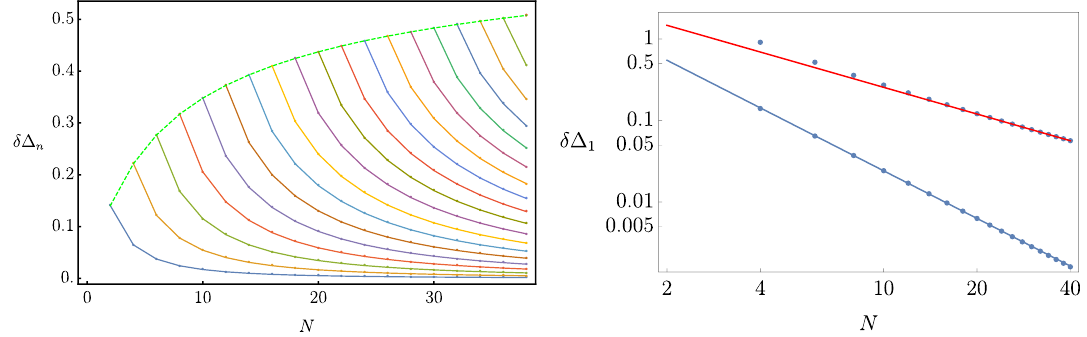
= 2(cid:1) (cid:30) with 0